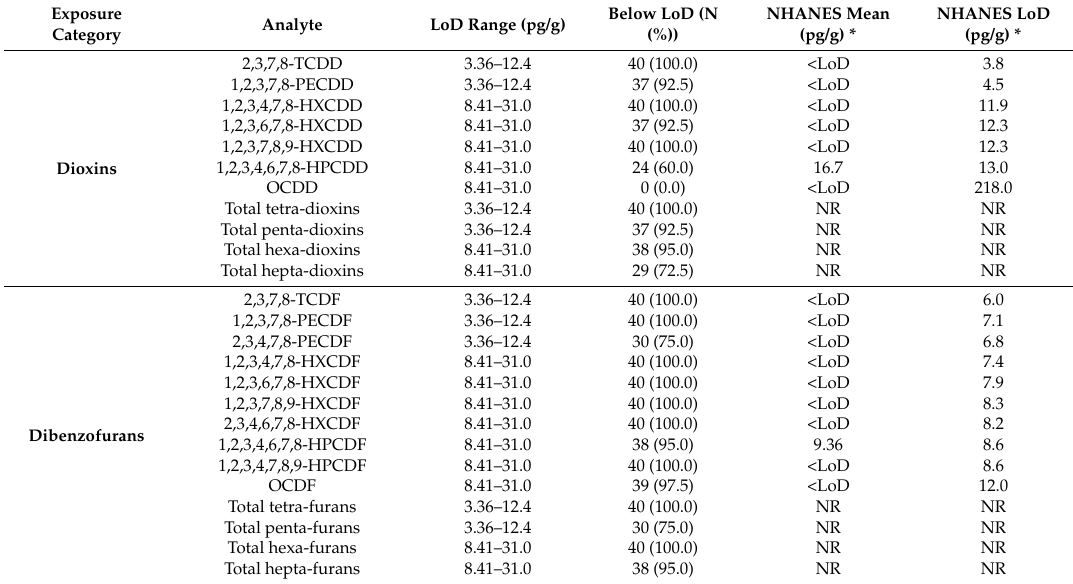
Table 2. Limit of detection (LoD) of dioxin and dibenzofuran analytes in serum (N = 40) as compared with LoDs reported by the National Health and Nutrition Health Examination Survey